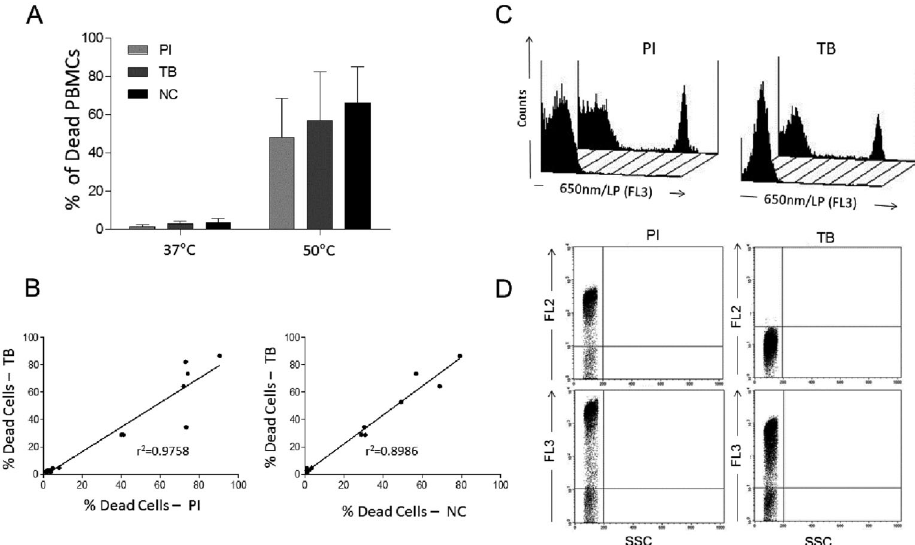
Figure 5. A , Comparison of the trypan blue (TB) exclusion test using flow cytometry, propidium iodide (PI) staining and the conventional trypan blue exclusion test employing cell counting in a Neubauer chamber (NC). B , Pearson’s correlation test between PI and TB or NC and TB. C , Fluorescence intensity histogram profiles of the PI and TB flow cytometry analysis. D , Fluorescence emitted by cells stained with PI and TB dyes and analyzed on FL2 (585/42) and FL3 (650 nm/LP) detectors.